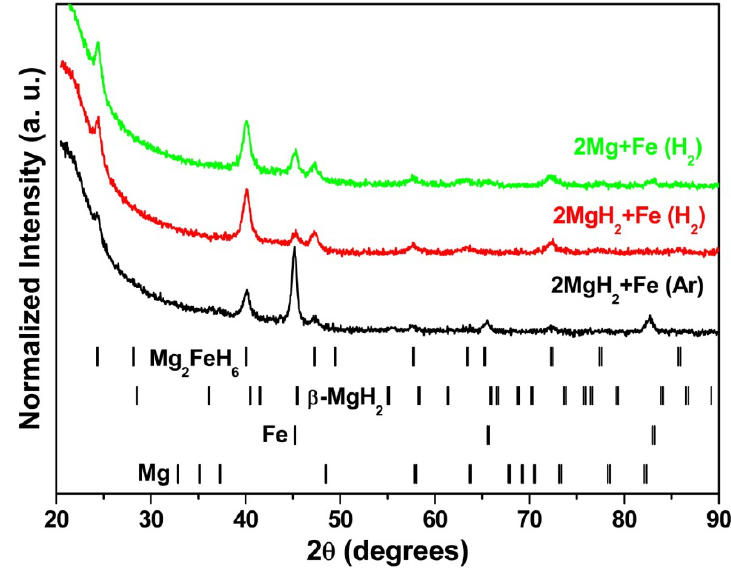
Figure 1. XRPD patterns of ball milled samples. The position of X-ray diffraction peaks for the identified phases are indicated below the patterns.